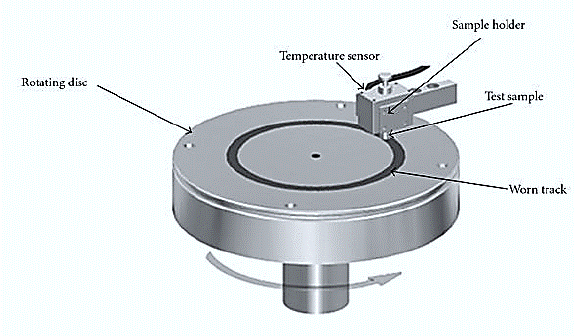
Figure 4: Pin on disk wear test